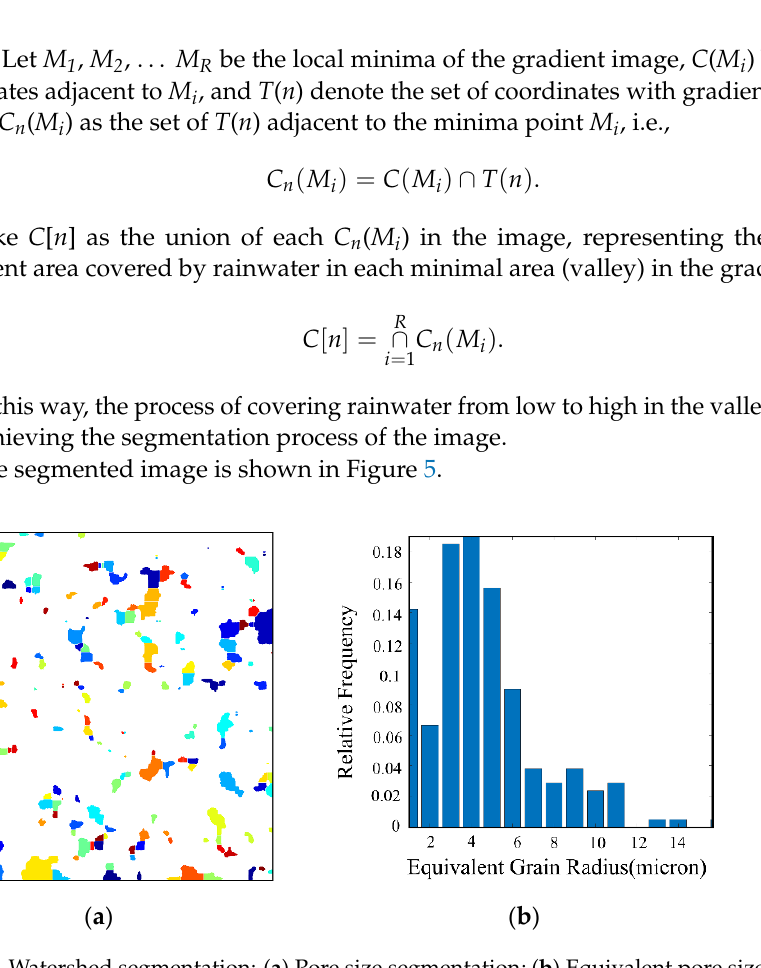
Figure 5. Watershed segmentation: ( a ) Pore size segmentation; ( b ) Equivalent pore size distribution.